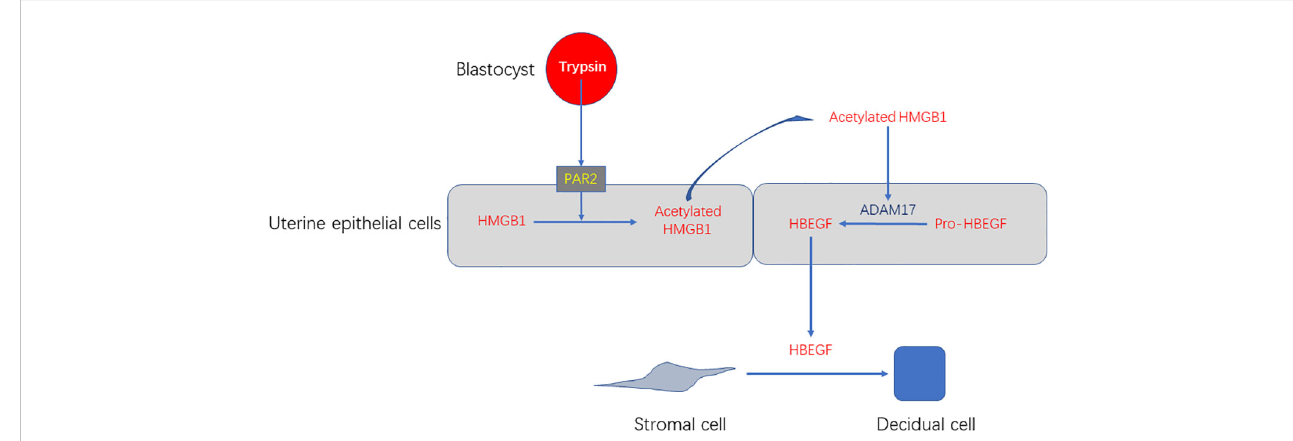
FIGURE 9 A working model showing that blastocyst-derived trypsin induces decidualization of stromal cells through